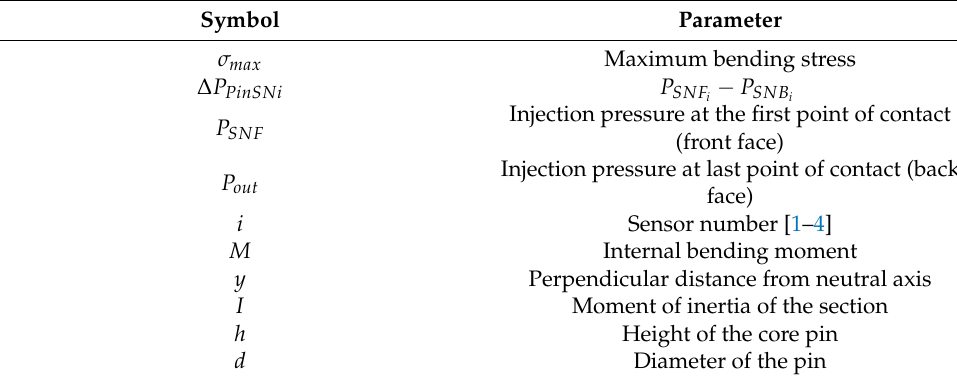
Table 4. Description of the